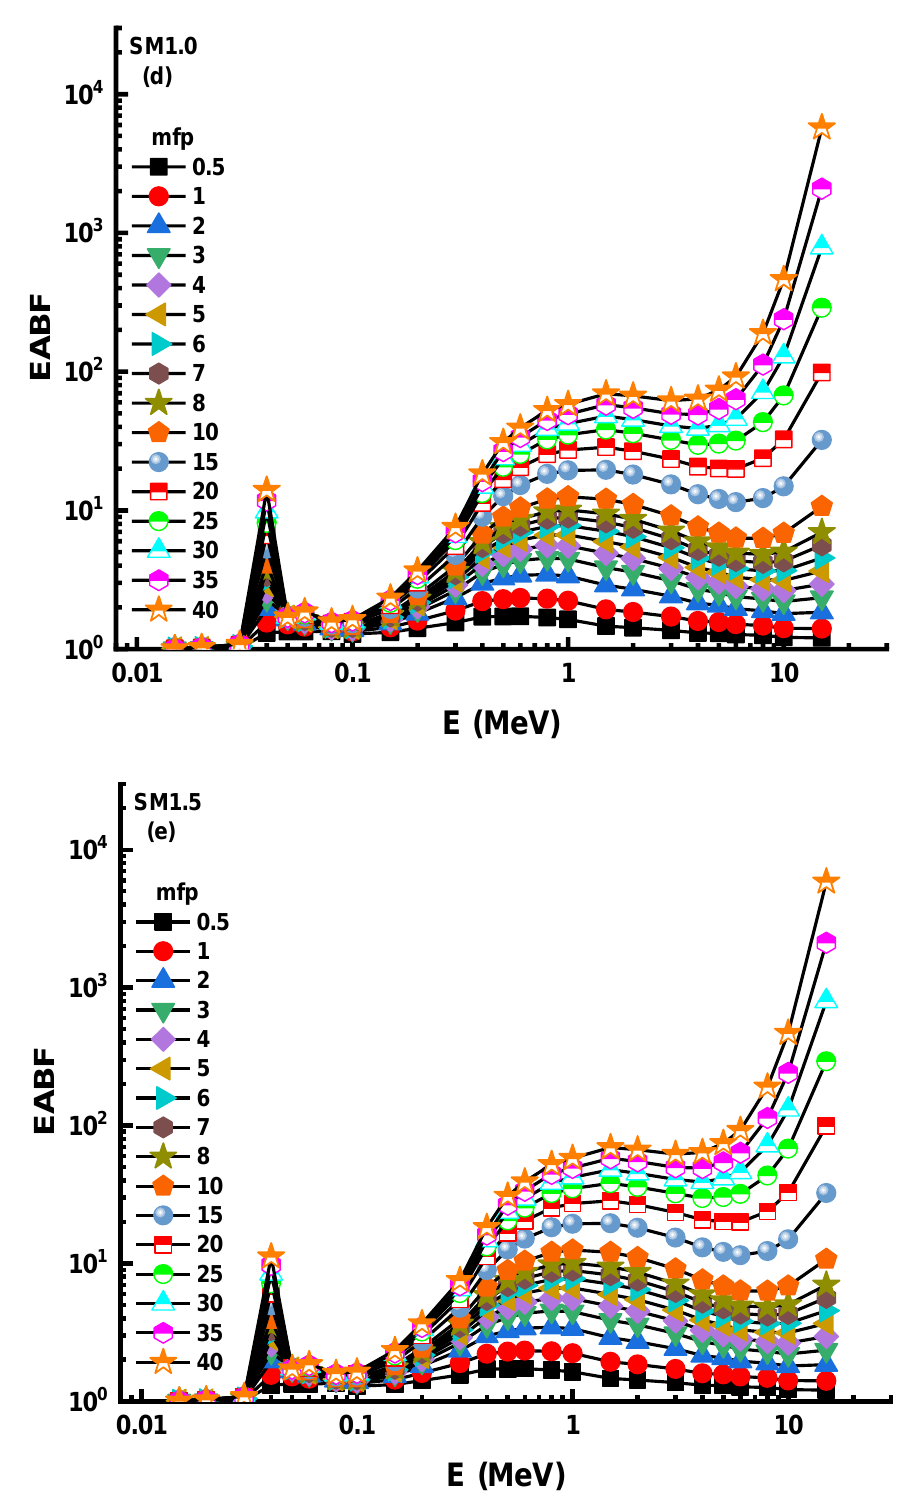
Figure 10. ( a – e ) . Variation of energy absorption buildup factor (EABF) against Photon energy for all glasses. all